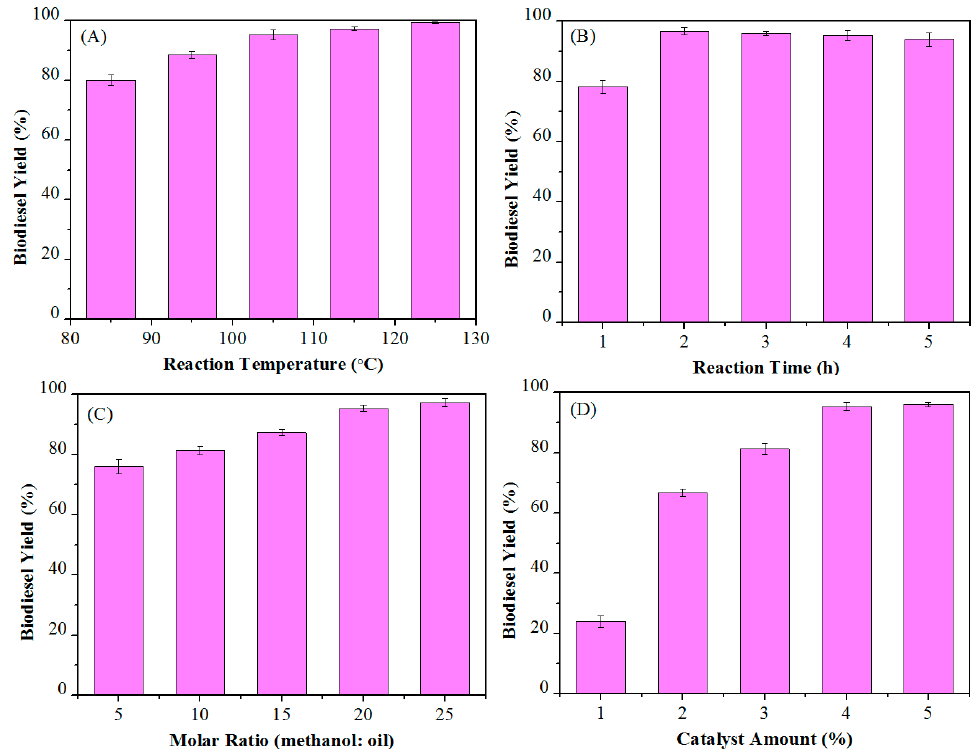
Figure 5. Single-factor optimization of biodiesel production from Jatropha oil (acid value: 6.75 mg KOH/g) catalyzed by the Ca-B(700) catalyst: ( A ) reaction temperature, ( B ) reaction time, ( C ) methanol/oil molar ratio, and ( D ) catalyst dosage.